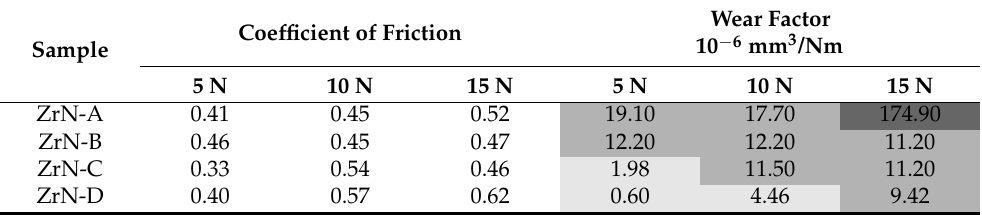
Table 2. Coefficient of friction and wear factor measured applying normal load of 5, 10, and 15 N at sliding speed of 2 cm/s.